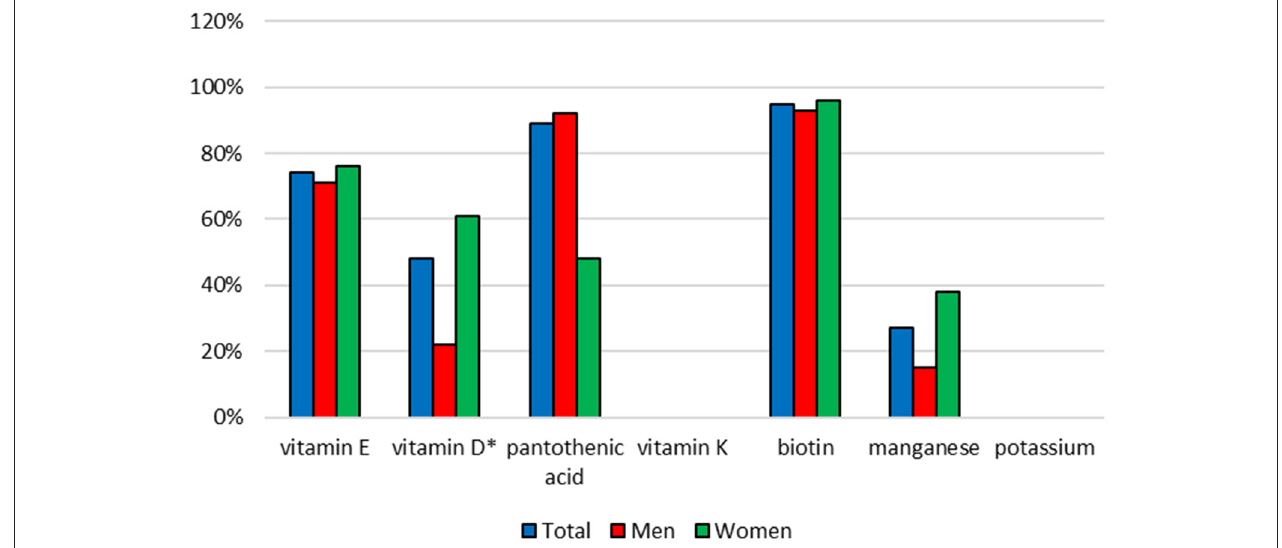
FIGURE 5 | Percentage of people whose intake of vitamins or minerals from food supplements was higher than the AI value. *statistically significant difference, chi-square test, p < 0.05.